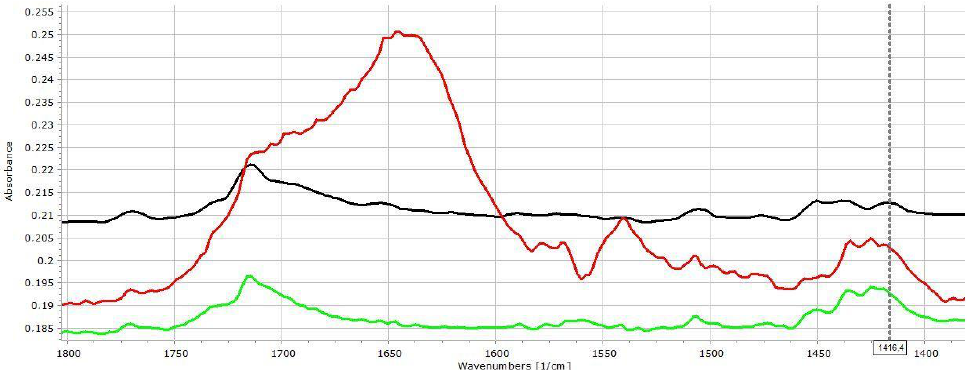
Figure 5. FT-IR spectra of ACE-PVC:EL 75:25 samples: original ( black ), dipped ( red ), and dried ( green ).